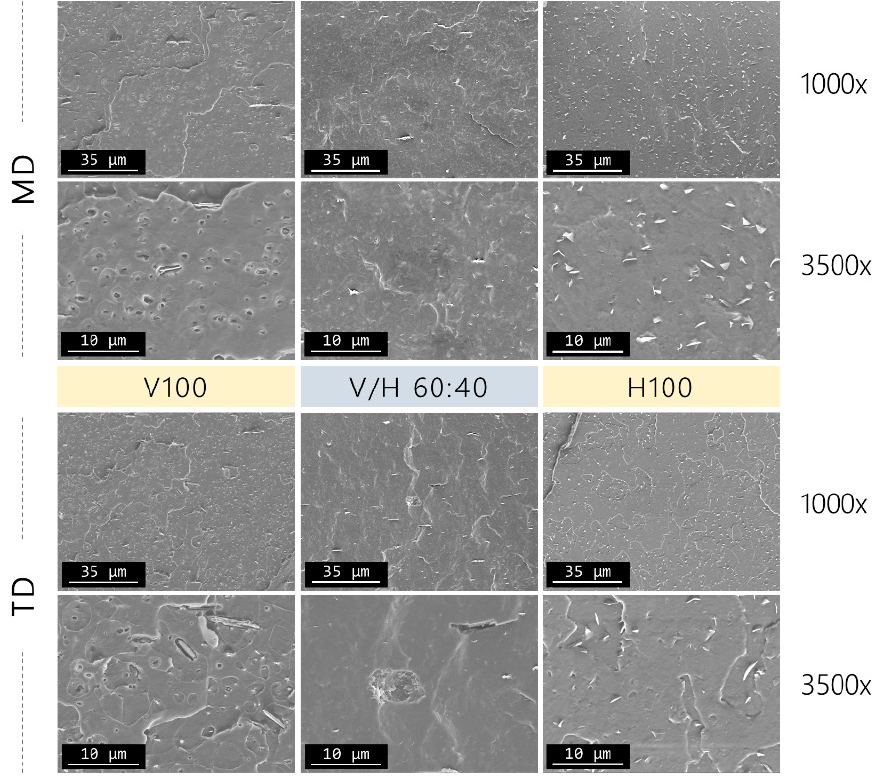
Figure 3. Scanning electron microscopy (SEM) micrographs of neat poly(3-hydroxybutyrate- co -3- valerate) (PHBV) and poly(3-hydroxybutyrate- co -3-hydroxyhexanoate) (PHBH) and their blend V/H 60:40 at two different magnifications per extrusion direction. Machine direction (MD), up. Transversal direction (TD),